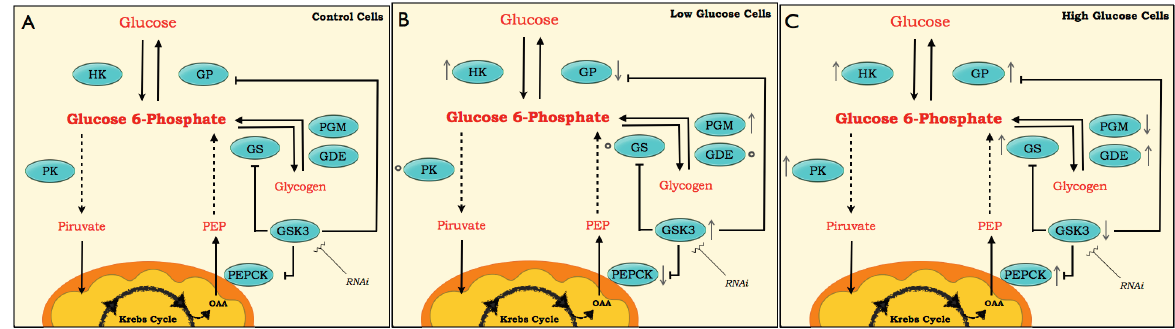
Figure 9. Scheme for pathways of glucose metabolism. The scheme is based on enzyme activities, metabolites and molecular changes in BME26 cells after glucose treatments. The enzymes studied are presented inside blue spheres (HK, PK, GS, GSK3, PGM, GDE, PEPCK and GP). Arrows next to the enzymes ( ) represent the oscillations in enzymatic activity and transcriptional response. Small spheres next enzymes ( ) indicate no variations in these enzymes or genes compared with the control. Dashed line involves several enzymes steps in the pathway, and solid lid represents one enzymatic step. The low-glucose ( B ) and high-glucose ( C ) are compared with the control ( A